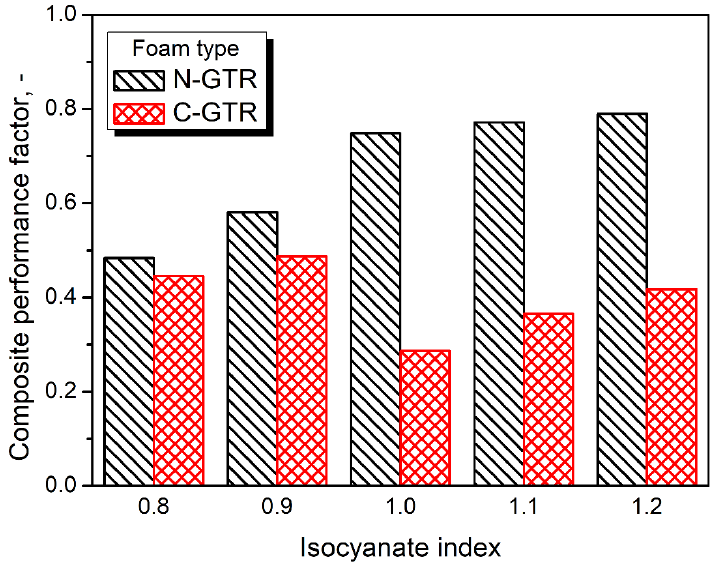
Figure 3. Values of composite performance factor for PU/GTR composites.